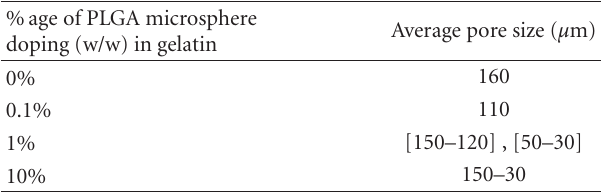
Table 1: E ff ect of microsphere doping on sca ff old microarchitec- ture. For each sca ff old, 50 pores were analyzed to get the average pore